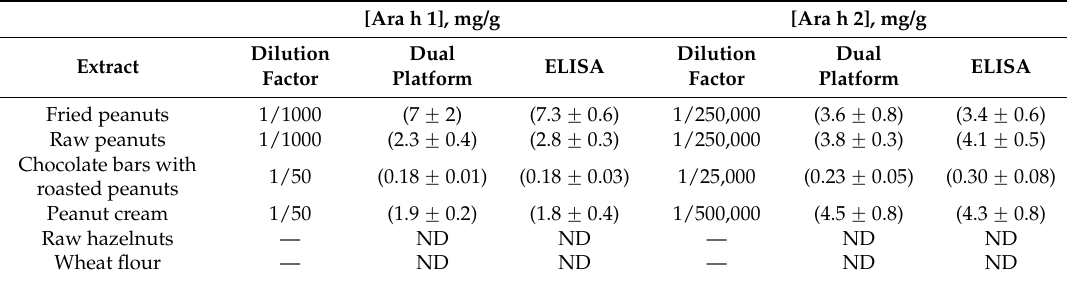
Table 2. Determination of the endogenous content of allergenic proteins Ara h 1 and Ara h 2 in different food extracts with the amperometric dual immunosensor and comparison with the results provided by ELISA spectrophotometric